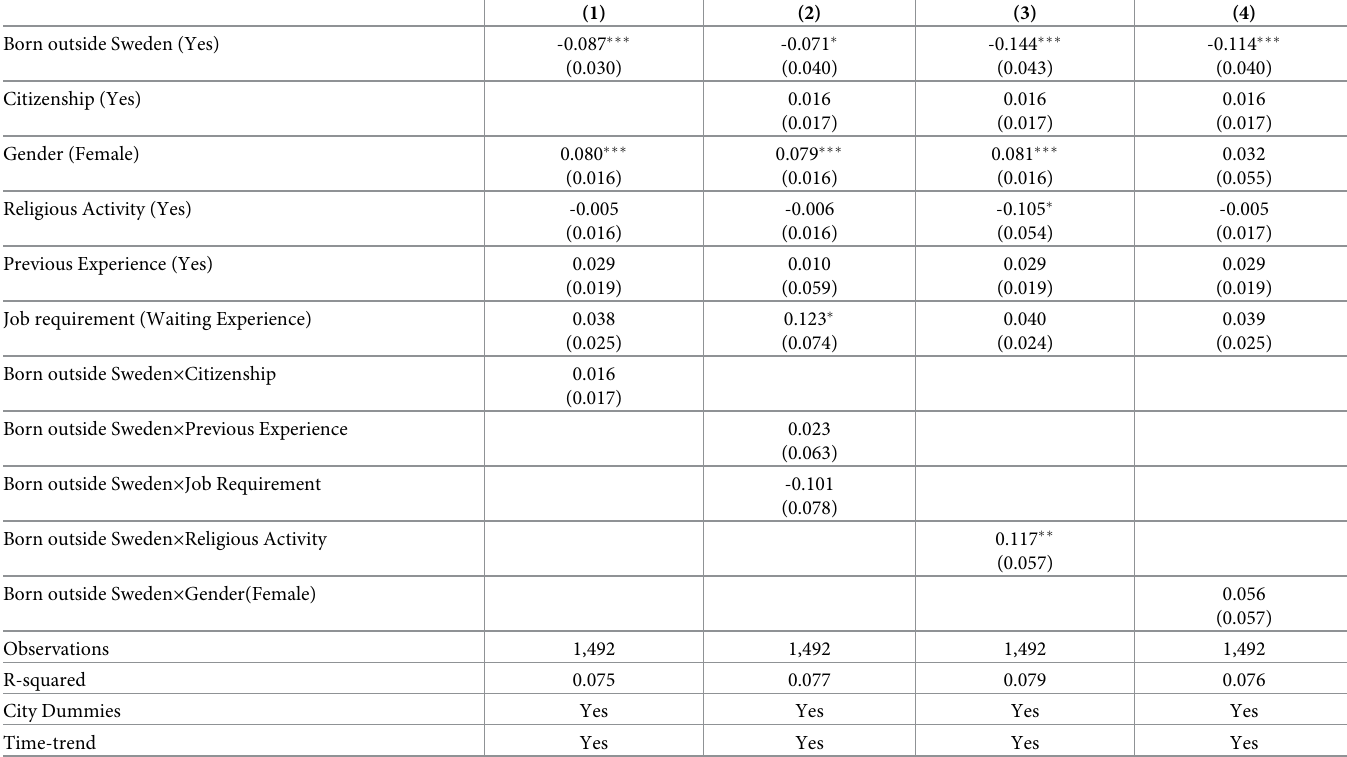
Table 3. Heterogeneous effects of being born outside of Sweden. DV: Employer